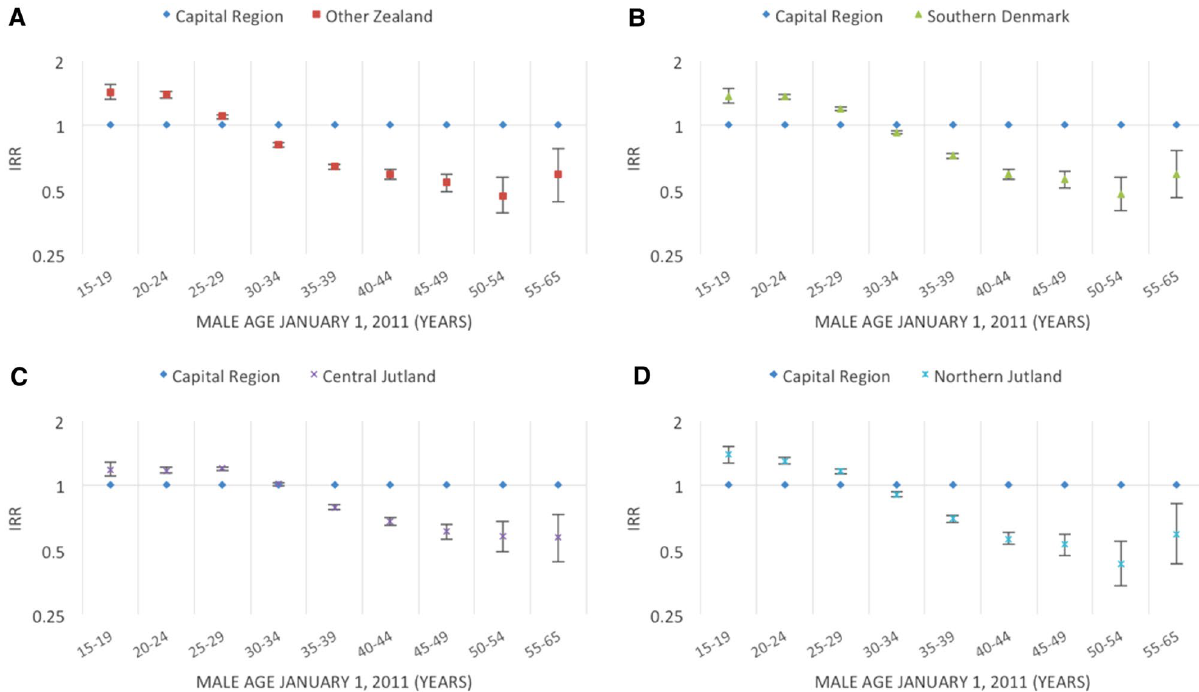
Figure 3. Incidence rate ratios (IRR) of fathering a child according to region of residency 1 and age 2 . Men aged 15–65 years living in Denmark January 1, 2011 to December 31, 2015. 1 Region of residency by January 1, 2011 categorised into one of the five administrative regions of Denmark: the Capital Region, Other Zealand, Southern Denmark, Central Jutland or Northern Jutland. 2 Age groups according to the man’s age by January 1,